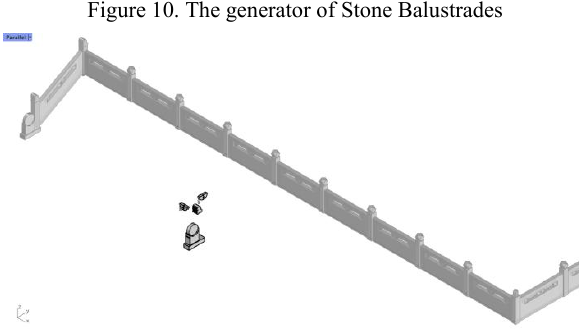
Figure 10. The generator of Stone Balustrades